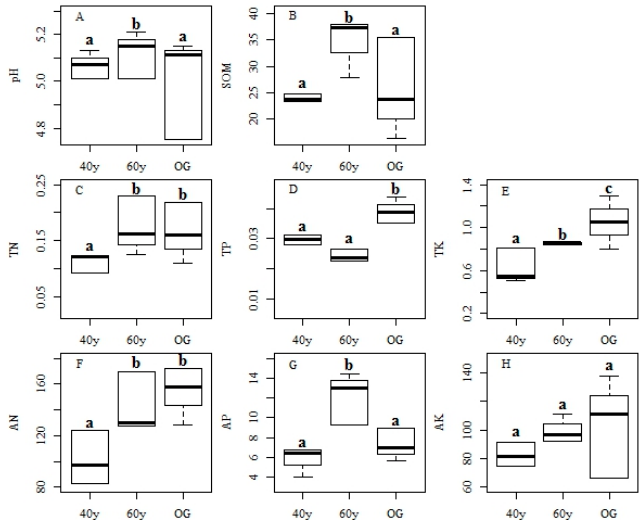
Figure 6. Comparison of soil nutrient factors (mean ± SD) during succession in tropical monsoon forests. Subfigures ( A – H ) respectively showed the changes of soil pH (pH), soil organic matter content (SOM), total nitrogen content (TN), total phosphorus content (TP), total potassium content (TK), available nitrogen content (AN), available phosphorus content (AP), available potassium content (AK). The successional stages were 40-year-old forests (40y), 60-year-old forests (60y) and old-growth forests (OG). Different letters (a, b, c) demonstrated significant different at p <